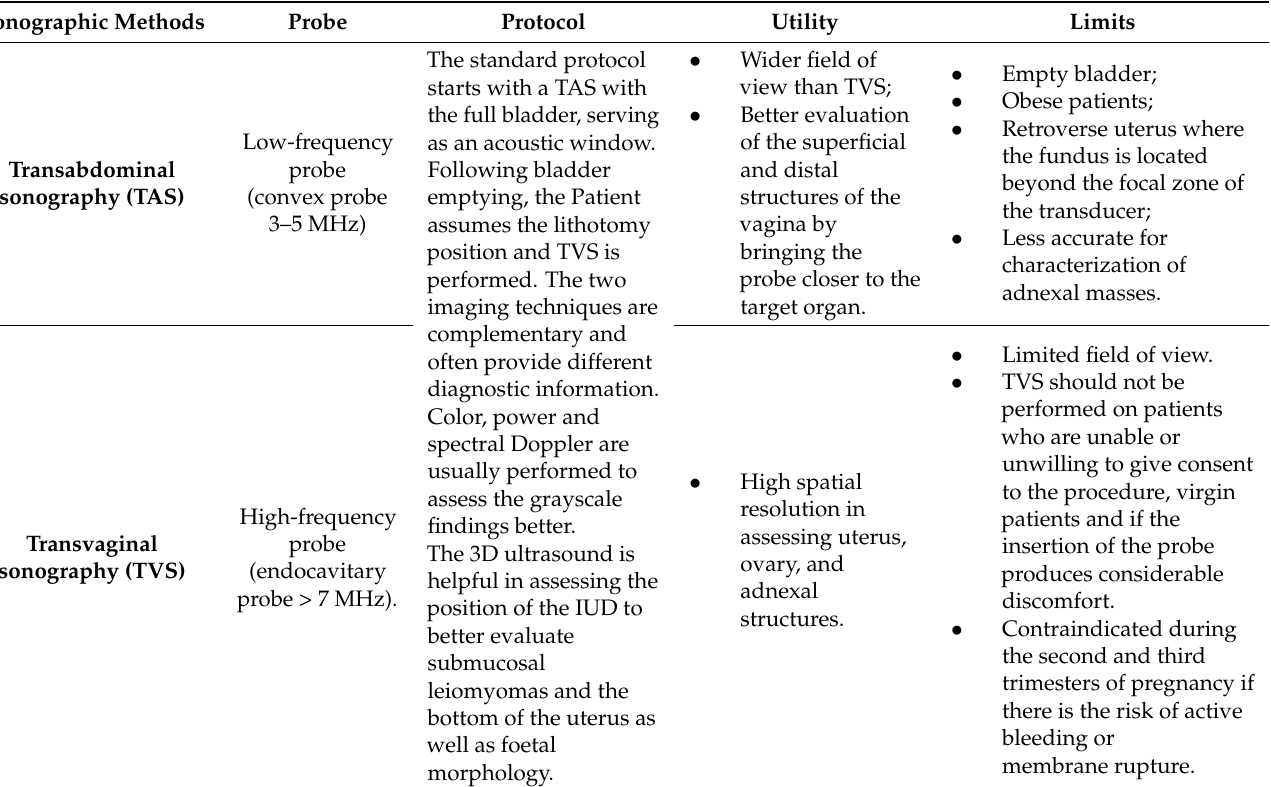
Table 1. Sonographic methods, protocol, utility, and limits for examining the female